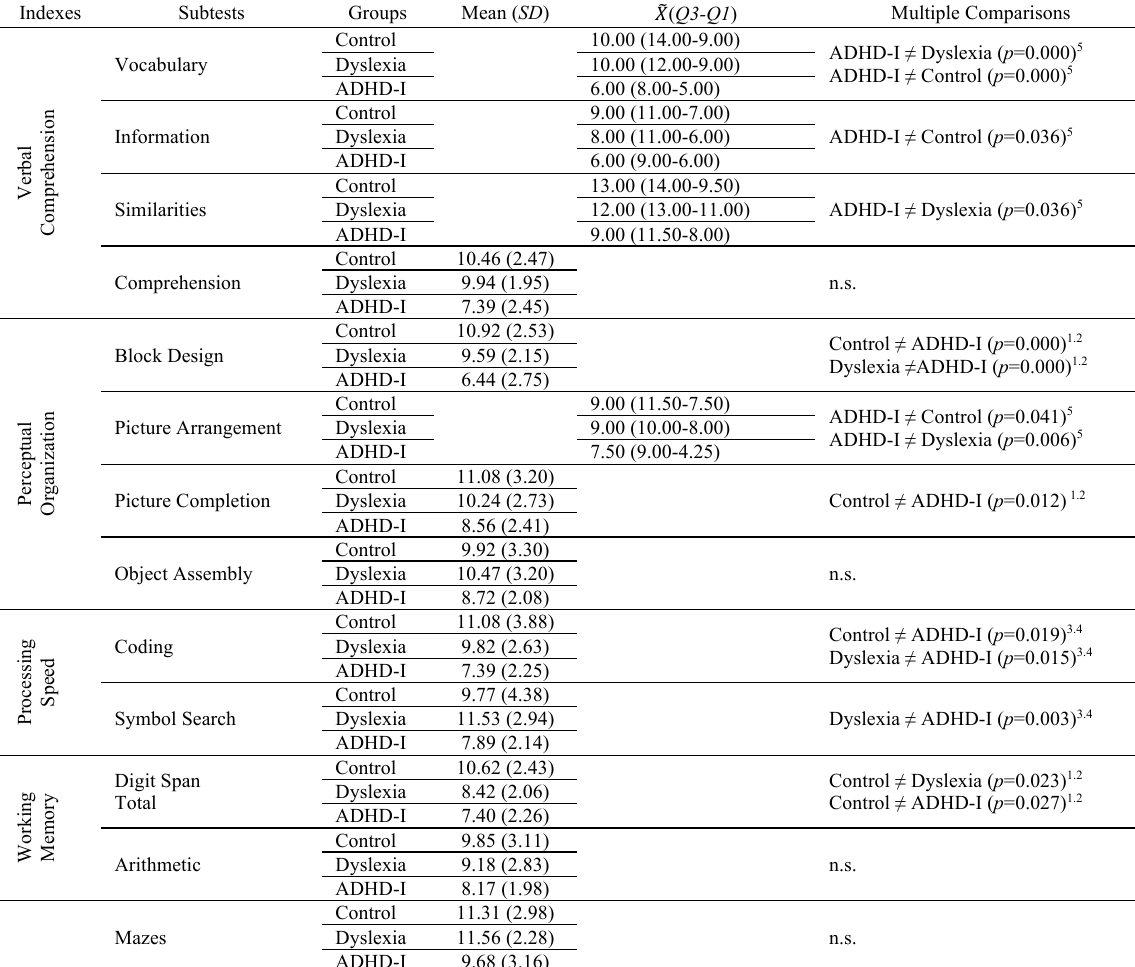
Table 11 - Means, standard deviations, median, 1 st and 3 rd percentiles, ANOVA and Kruskal-Wallis independent samples: WISC-III subtest results.